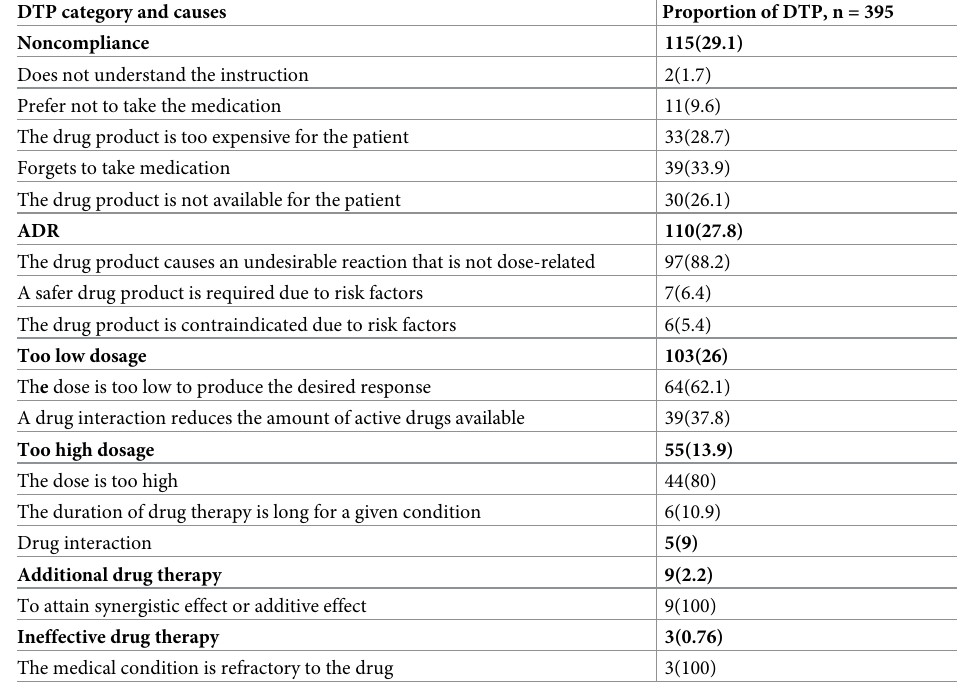
Table 4. Types and cause of DTP among epileptic patients at the ambulatory clinic of JMC, 2021.